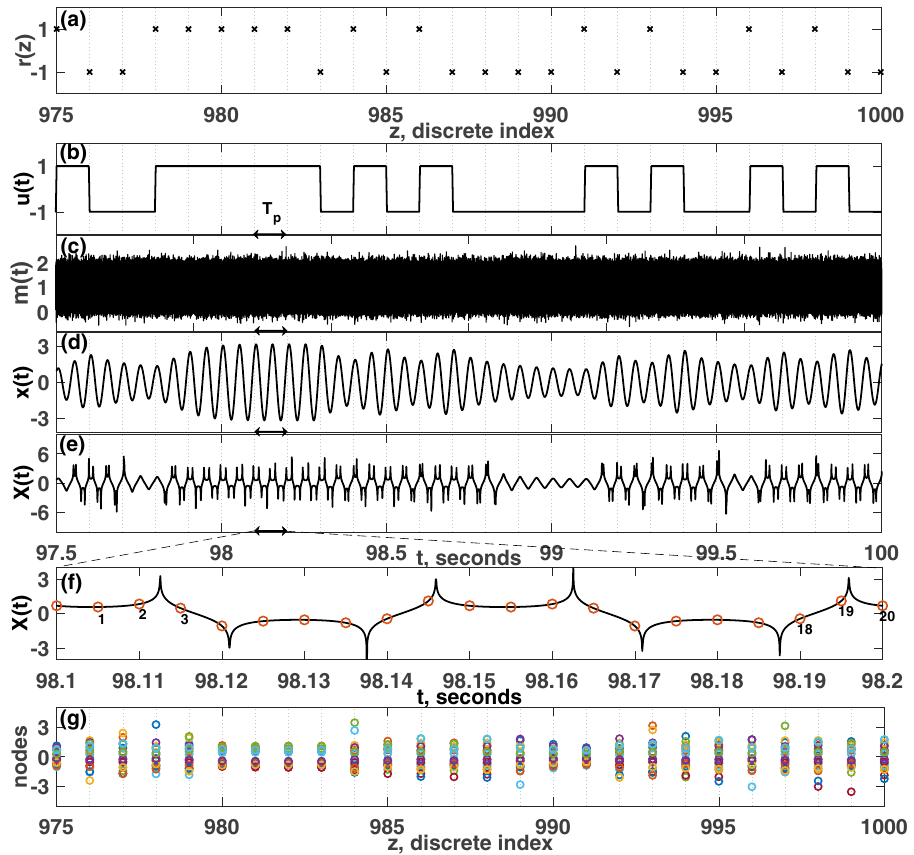
Figure 1. ( a ) Discrete random binary signal, r ( z ). ( b ) Continuous input signal, u ( t ). ( c ) Stochastic masking function, m ( t ). ( d ) Time history of x ( t ). ( e ) Rescaled time history, X ( t ). ( f ) 20 equidistant nodes for a single pseudo-period, T p , are denoted with circles. ( g ) Collected nodal states from the nodes for machine learning input data set. Different colors in ( g ) denote different nodes. For the simulation depicted here, the parameters were set such that: µ = 5 , A = 0.5 , � = 40 π rad/s, ω 0 = 40 π rad/s, T p = 0.1 seconds, N = 20 nodes, φ = π/ 3 rad, σ = 100 , β = 1.0